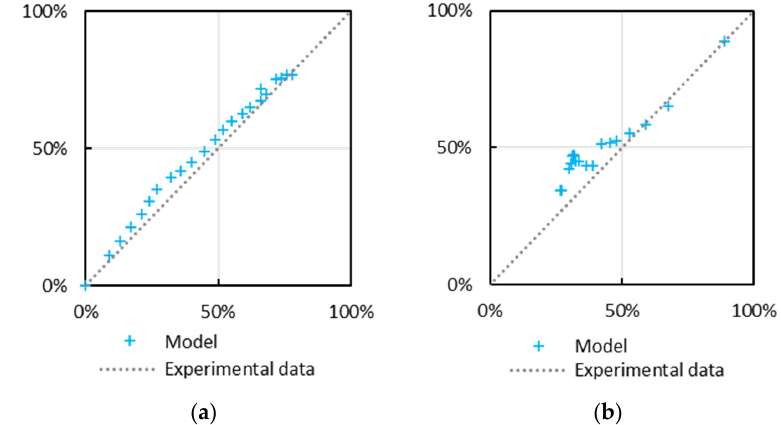
Figure 13. Exponential decay/growth model for CaCl 2 moisture desorption.